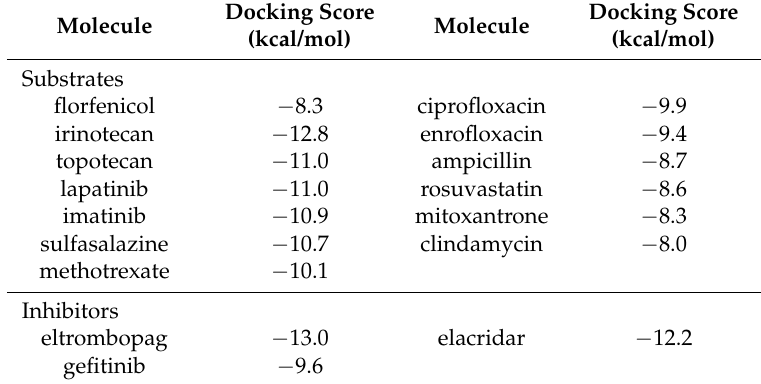
Table 2. Docking scores of breast cancer resistance protein (BCRP) substrates and inhibitors into the efflux pump site.